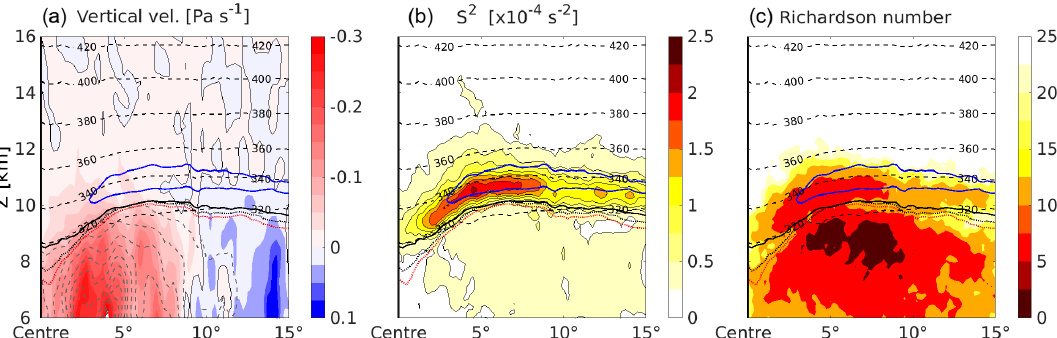
Figure 10. Vertical tropopause-based averaged cross section as in Fig. 9, but only north of the cyclone centre. (a) Filled contours show mean vertical velocity, solid thin black line the ω = 0Pas − 1 isoline. Grey dashed lines are isolines of the cloud ice water content, steps as in Fig. 9. (b) Filled contour and solid black contour lines show squared vertical shear of horizontal wind S 2 . (c) Modified Richardson number mean Ri , with an inverted colour scale (red represents low values) to highlight the tendency toward turbulent motion. Blue solid bold line in all three panels shows the N 2 mean = 6 × 10 − 4 s − 2 isoline, dashed black lines the isentropes.